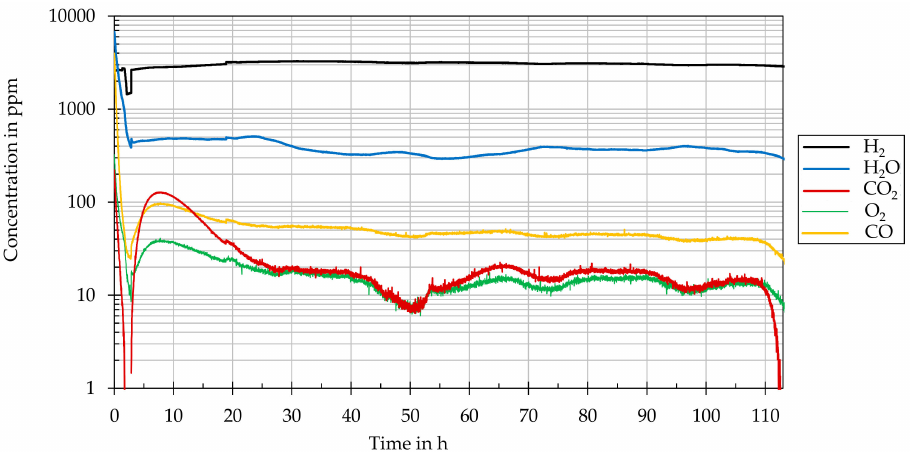
Figure 12. Representation of gaseous reaction products and impurities in the cooling gas helium during thermal annealing of Alloy 800H.